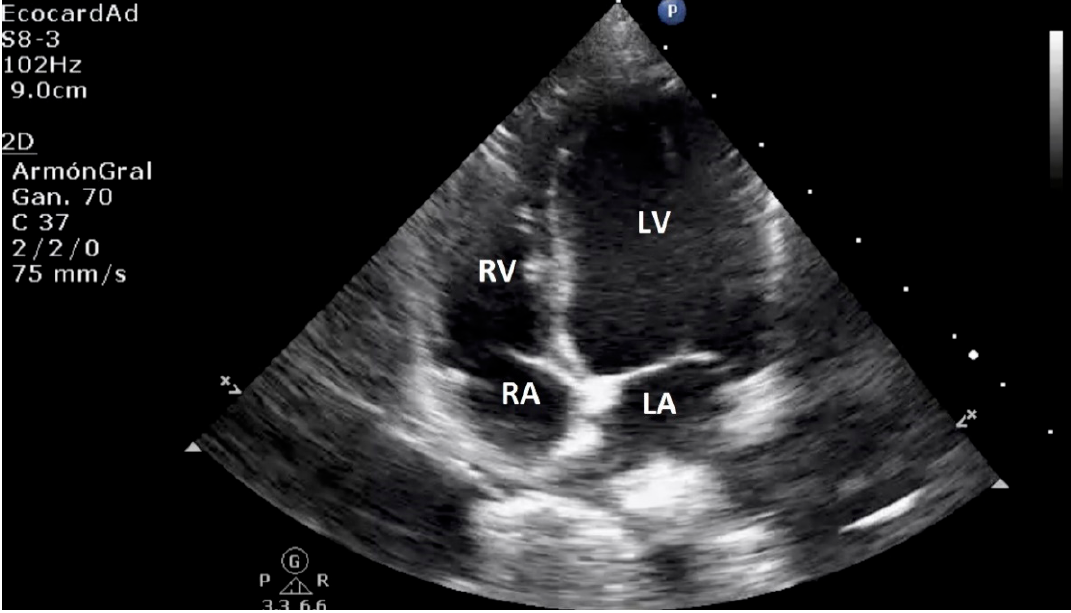
Figure 3. Right parasternal 4 chamber apical view demonstrates left and right ventricle, left and right atrium, and atrioventricular valve.